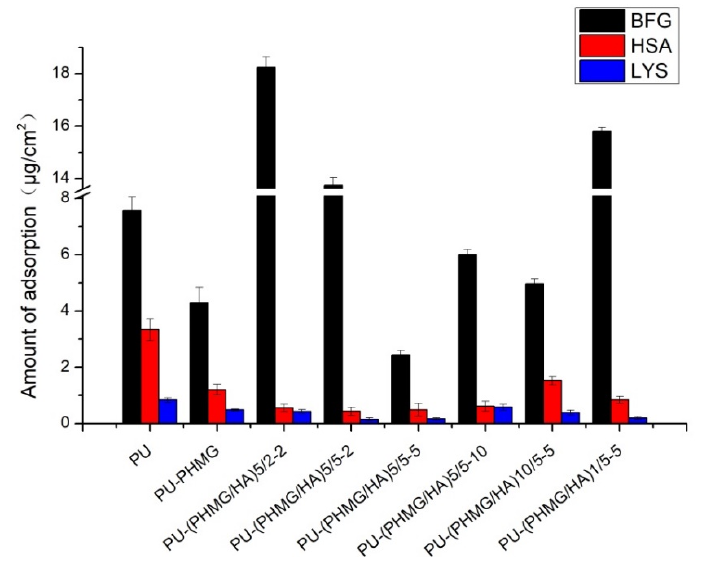
Figure 5. Protein adsorption on films.